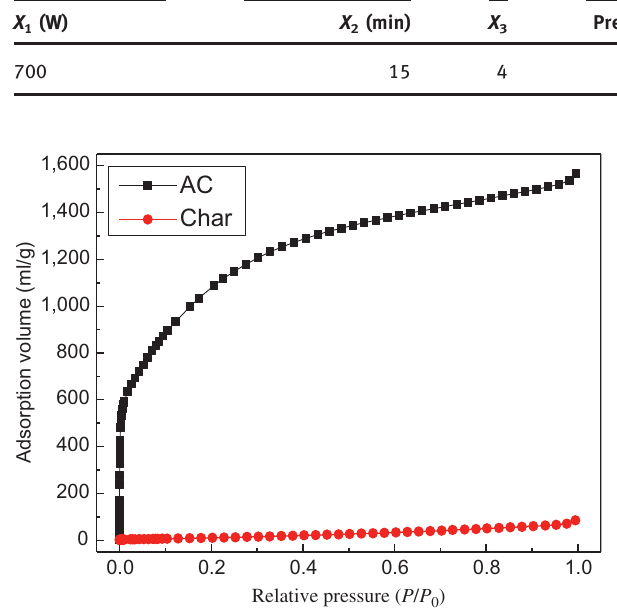
Figure 6: Nitrogen adsorption isotherm of the AC and char.